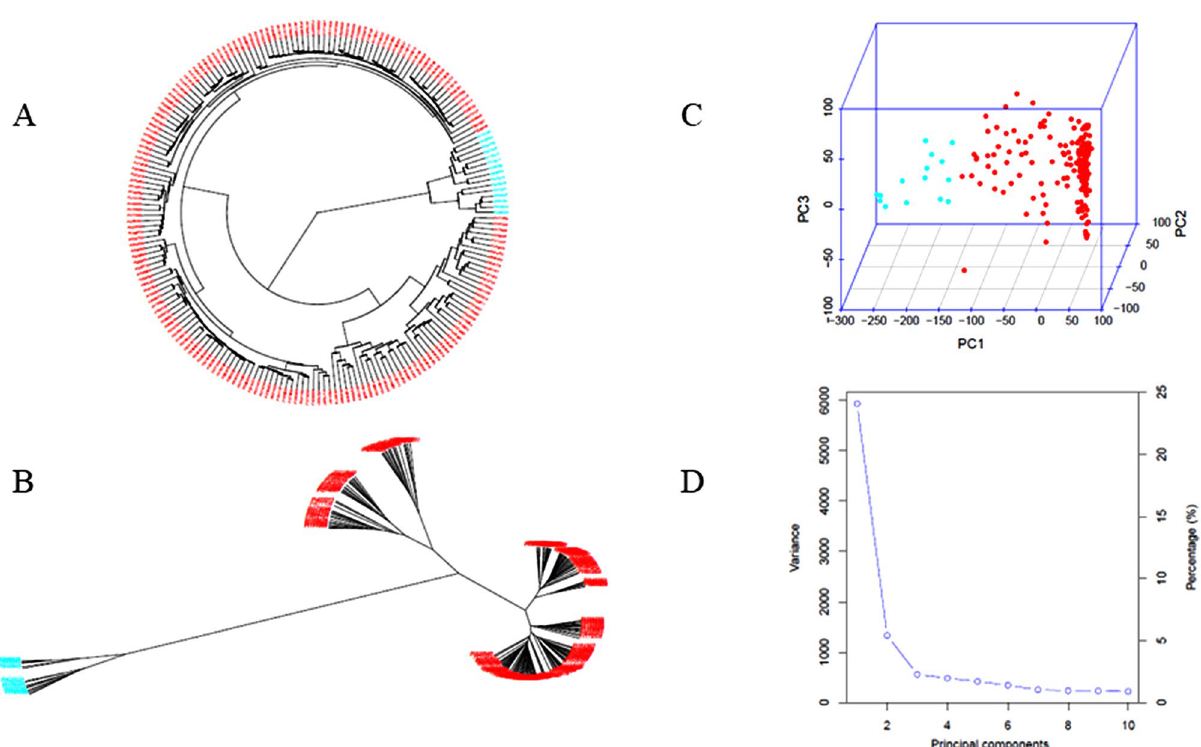
Figure 2. Population genetic diversity analysis of 201 USDA spinach accessions. Phylogenetic trees drawn by neighbor-joining (NJ) method showing in (fan) ( A ). unrooted ( B ), and 3D graphical plot of the principal component analysis (PCA) in two sub-population ( C ) and PCA eigenvalue plot drawn ( D ) drawn by GAPIT 3. A readable phylogenetic tree for each accession is shown in Supplementary Fig.